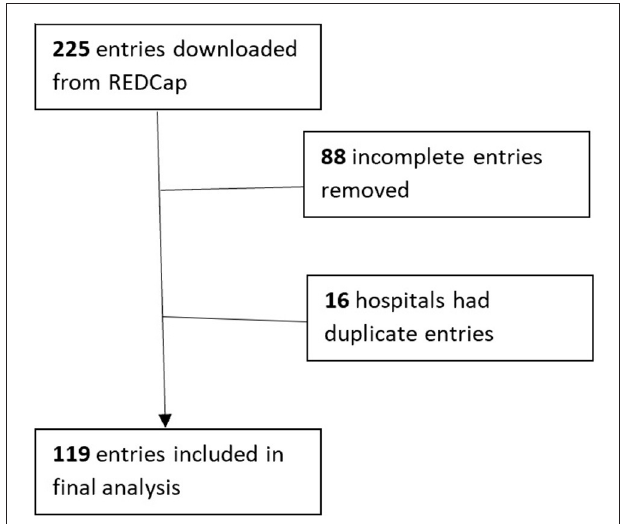
FIGURE 1 | Inclusion of survey responses.